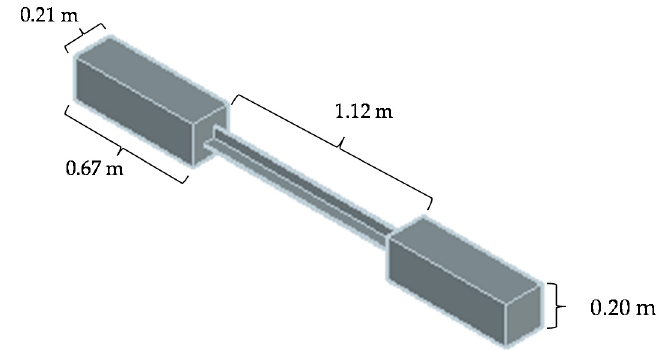
Figure 1. 3D drawing of the bi-block concrete sleepers.